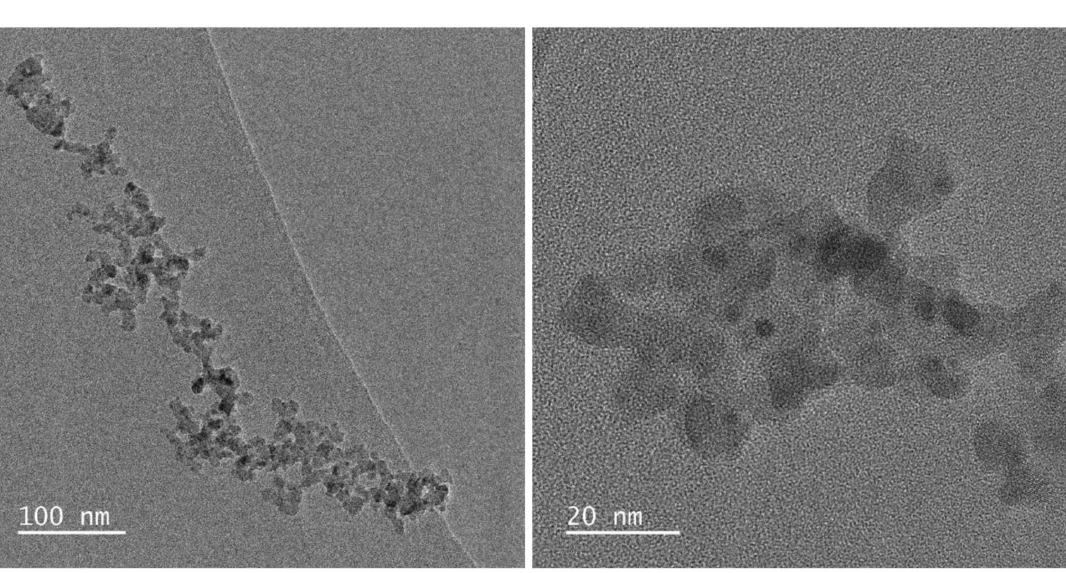
Figure 1. Representative transmission electron microscopy (TEM) images of the common BSCF batch (C TM = 0.1 M, FR PS = 50 mL · min − 1 and FR DG = 25 L · min − 1 )—the batch which is in common for all three synthesis parameter investigations—as an example for all BSCF batches. The particle size ranges roughly between 5 and 15